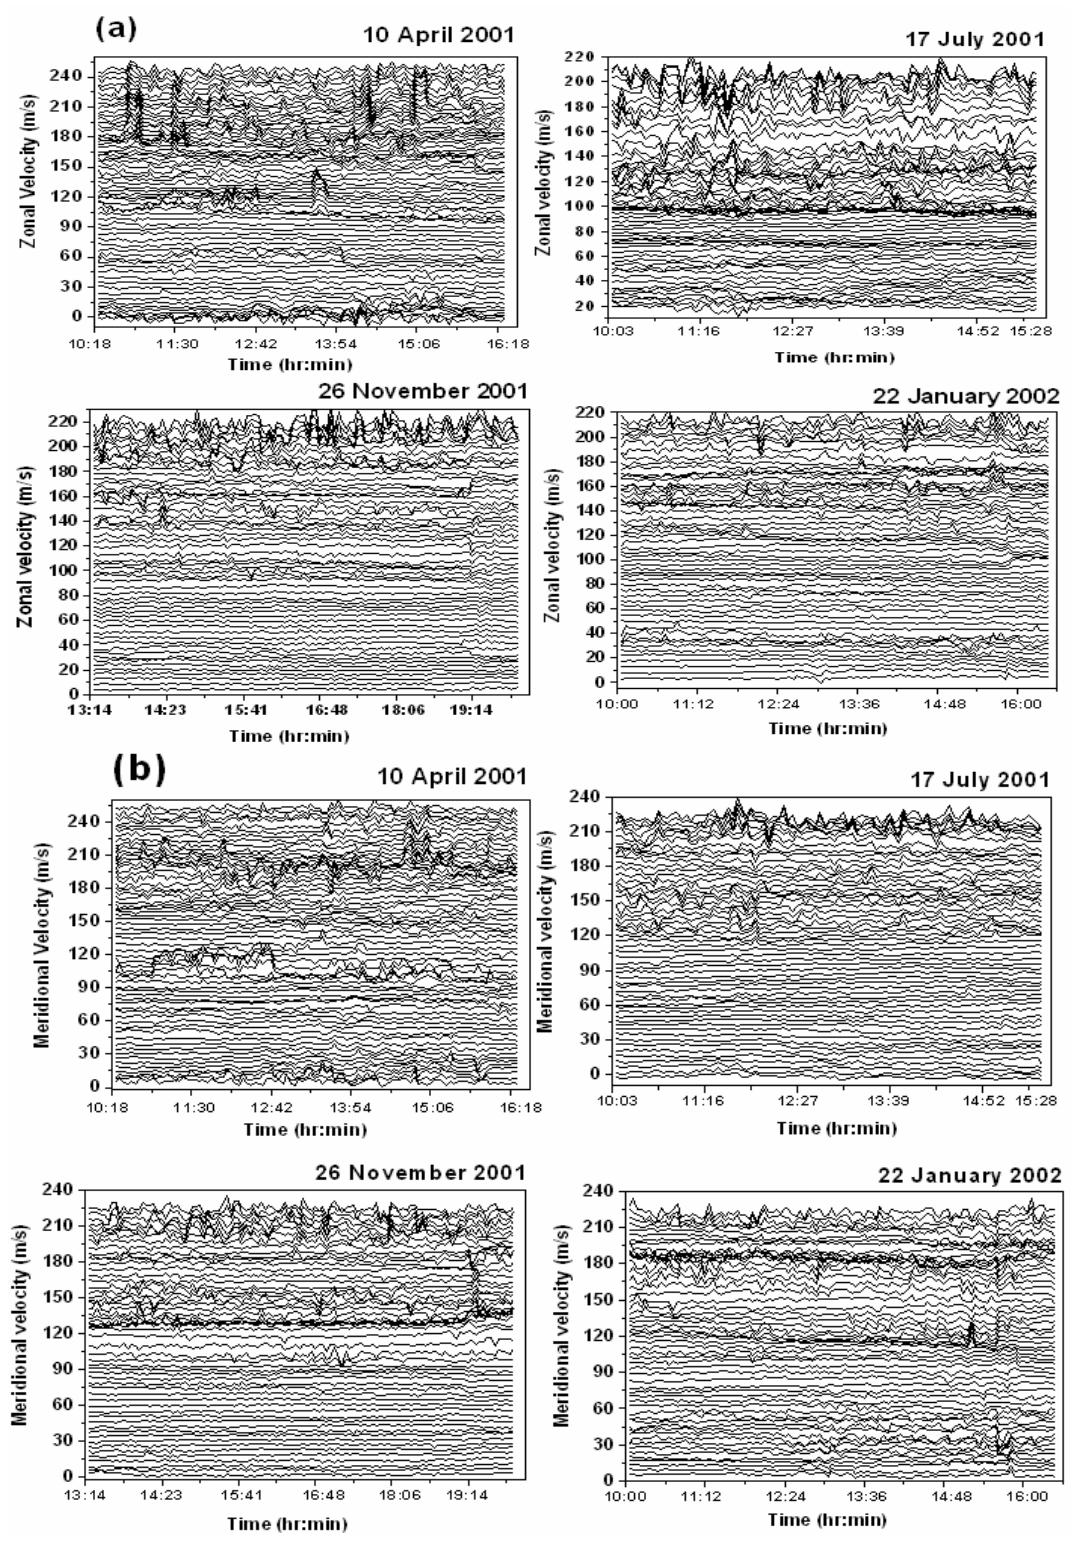
Fig. 2. Time series of (a) zonal and (b) meridional velocities during 10 April 2001, 17 July 2001, 26 November 2001 and 22 January 2002 for a 6-h period of observations on a typical day in different seasons. For clarity each profile (300-m height resolution) has been shifted by 4m/s for zonal and meridional